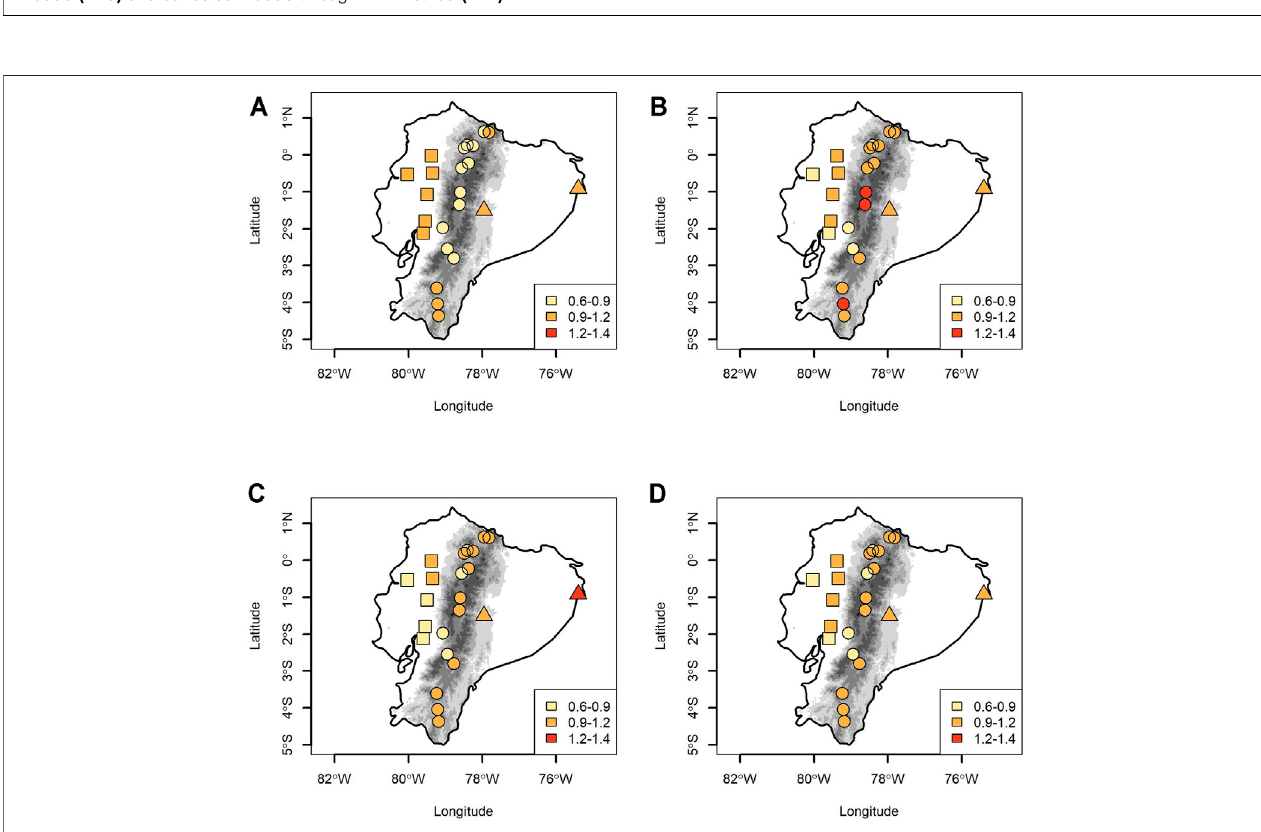
FIGURE 3 | High risk warming (HRW) mean value for the period 2011 – 2040 from CSIRO (A) , GISS (B) , and IPSL (C) . Figure 3D is the ensemble that explains the median from three WGCMs.